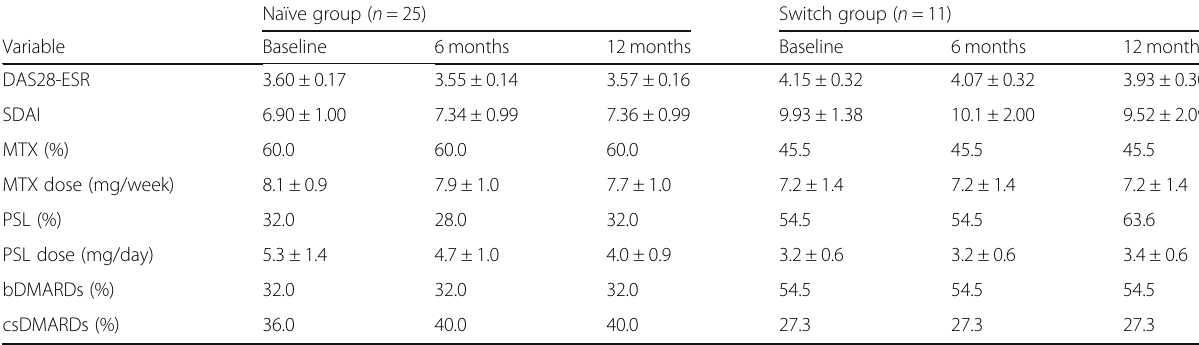
Table 3 Changes of disease activities and medications